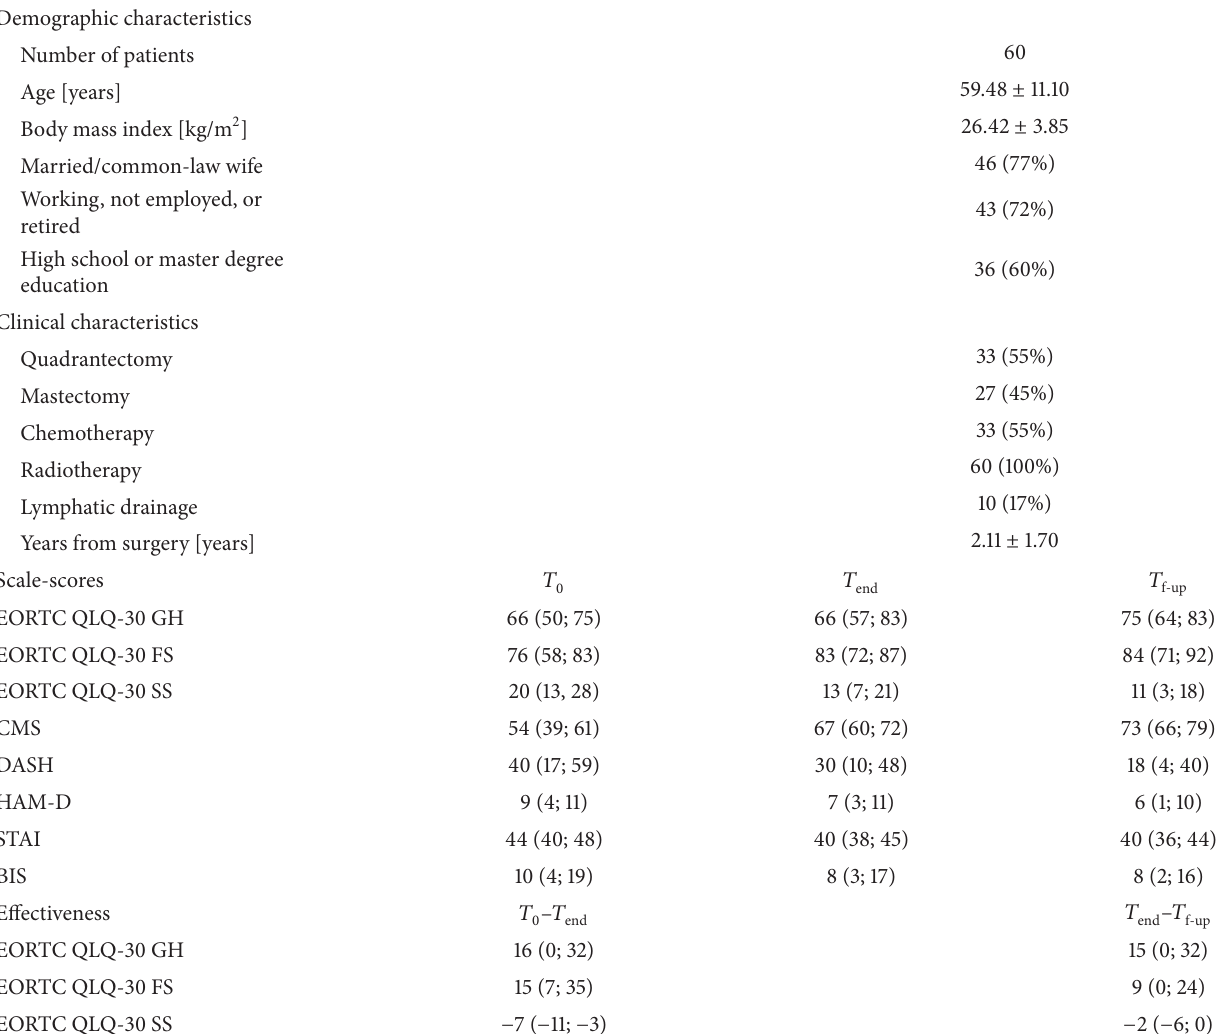
Table 2: Demographic and clinical characteristics of the sample. Cases (and percentages) or mean ± standard deviation of demographic and clinical characteristics of the sample. Median (1st; 3rd quartiles) for the scale scores. 𝑇 0 : baseline; 𝑇 month follow-up; QoL: quality of life; DASH: Disabilities of the Arm, Shoulder, and Hand Questionnaire; BIS: Body Image Scale; HAM-D: Hamilton Rating Scale for Depression; CMS: Constant-Murley Score; EORTC QLQ-C30: Quality of Life core questionnaire (GH: global health; FS: function scale; SS: symptom scale); STAI: State-Trait Anxiety